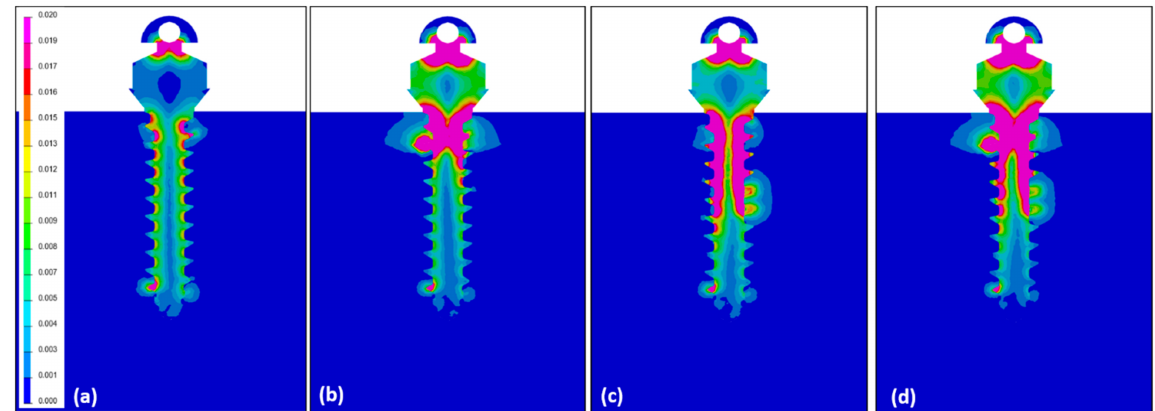
Figure 5. Illustrations showing the distribution of Von-Mises stress under counter-clockwise loading of 5 ◦ of the miniscrew: ( a ) In the control, the Von-Mises stress was distributed evenly and the amount of the stress was low; ( b ) In condition 1, a high Von-Mises stress was concentrated at the upper third of the orthodontic miniscrew; ( c ) condition 2 had a relatively even stress distribution, but the value was low as seen in Figure 4 and Table 2; ( d ) In condition 3, the stress was mostly concentrated at the upper third as in condition 1, but a quite high stress was focused at the middle notched